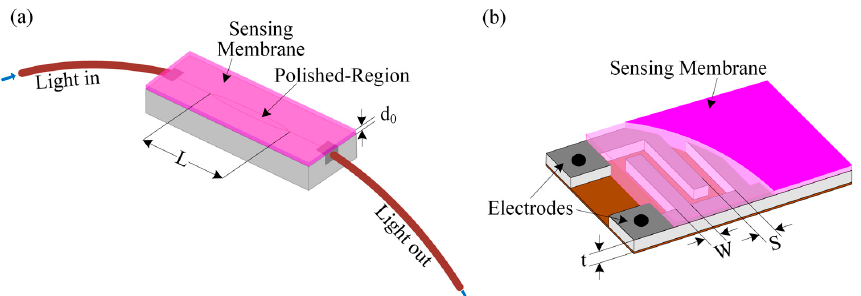
Figure 1. Schematic diagram of the temperature-sensing elements: ( a ) Side-polished optical fiber with a sensing membrane; and ( b ) IDC sensing element. a sensing membrane; and ( b ) IDC sensing